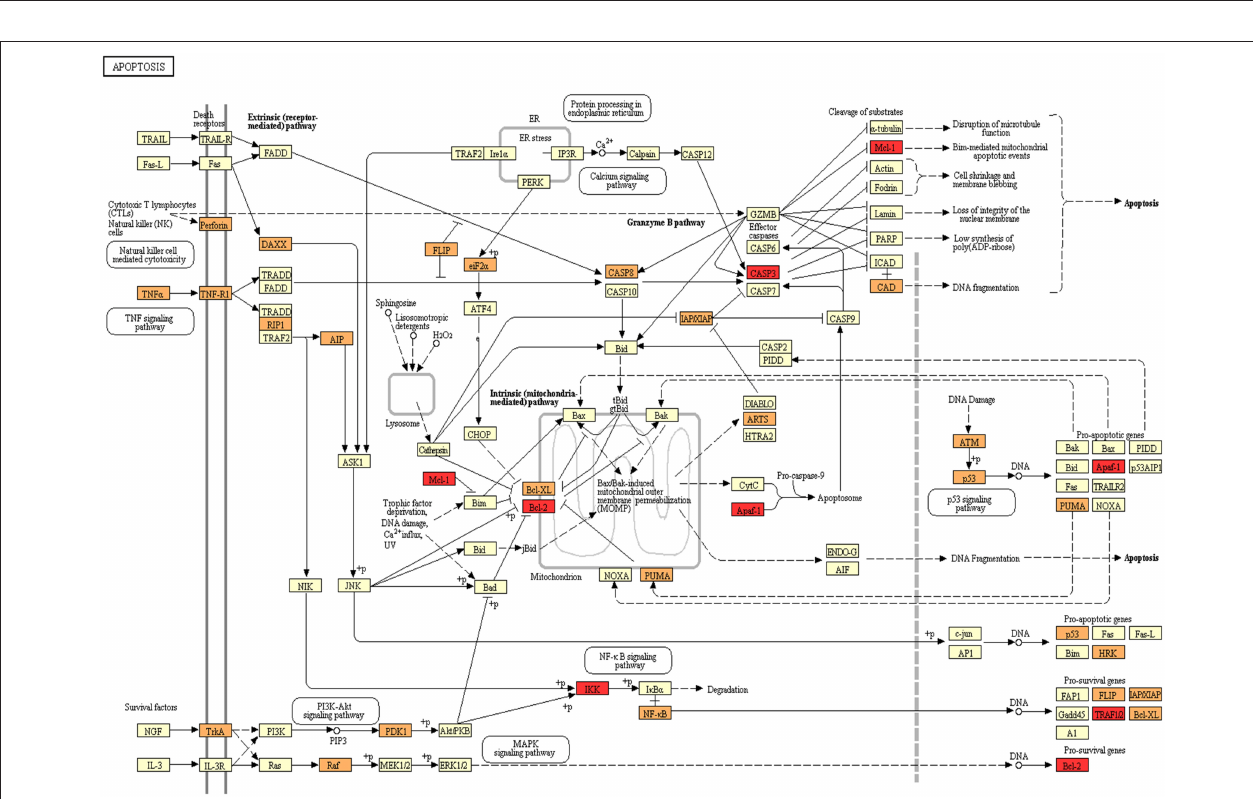
FIGURE 2 | potentially regulated by the microRNAs of the OT-CR differential profile. The analyses are derived from the IPA software. In this pathway, six microRNAs of the differential profile may target several molecules involved in the mechanisms of cell death. The numbers in the figure indicate the miRNAs and the arrows link to their respective targets. (1) miR-27a-5p (targets: RIP/RIPK1, BCL2 * ,TL1/TFNSF15 ), (2) miR-331-3p (targets: TNFTL1/TFNSF15, CASP9 ), (3) miR-885-5p (targets: CASP3 * , RAIDD/CRADD ), (4) miR-1233-3p (targets: TL1/TFNSF15, DFFB ), (5) miR-638: (targets: TBK1,TNF ), (6) miR-1260a (targets: DAXX, ASK1/MAP3K5, BCL2,TL1/TFNSF15 ). The *experimentally observed targets. The differences in microRNA expression are represented by the gradation of color intensity (hypoexpressed green and hyperexpressed red). The legend in the figure discriminates the prediction of the regulation of the targets. On the right side of the table we have the list of targets and the respective microRNAs involved in the pathway. *Experimentally demonstrated targets.